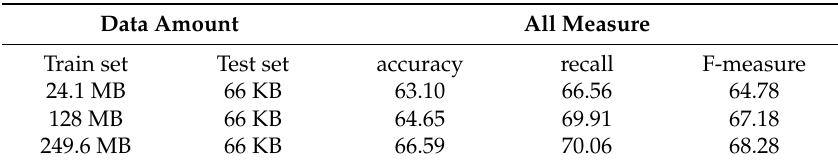
Table 9. Experimental results of all